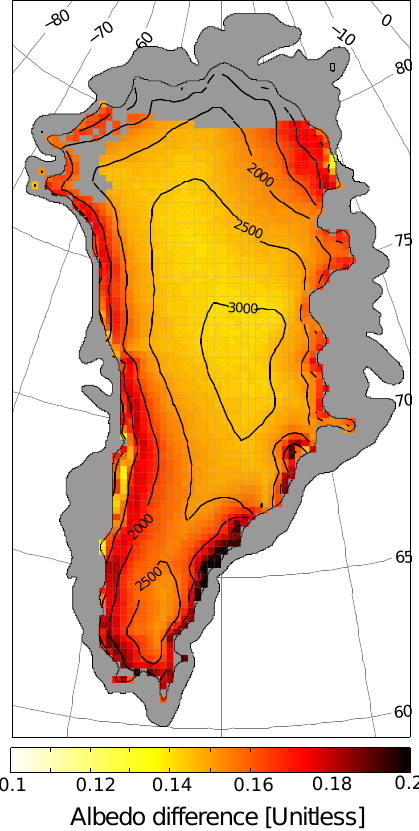
Figure 6. MCD43A3 BSA visible (0.3–0.7µm) minus MCD43A3 BSA SW (0.3–5µm) 2000–2013 JJA mean albedo (unitless) on the MAR grid. Areas not defined as 100% ice covered in MAR v3.2 were